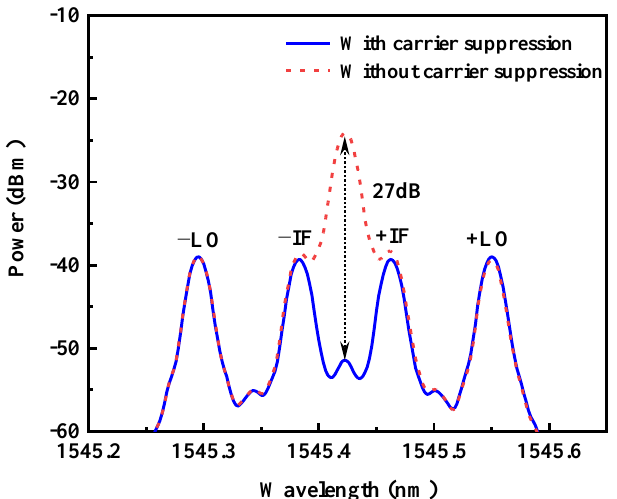
Figure 2. Measured optical spectra of the upper path before EDFA. Blue solid line stands for the DD-MZM working at the minimum point. Red dashed line stands for the DD-MZM working at the quadrature point.